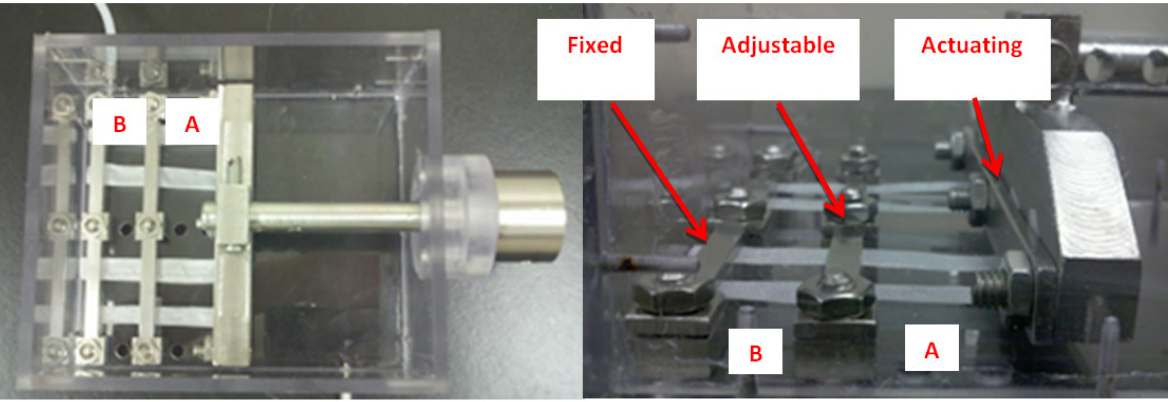
Figure 2. Bioreactor chamber clamp design. ( A ) Portion of the scaffold experiencing strain; ( B ) Portion of the scaffold that remains under 0% strain